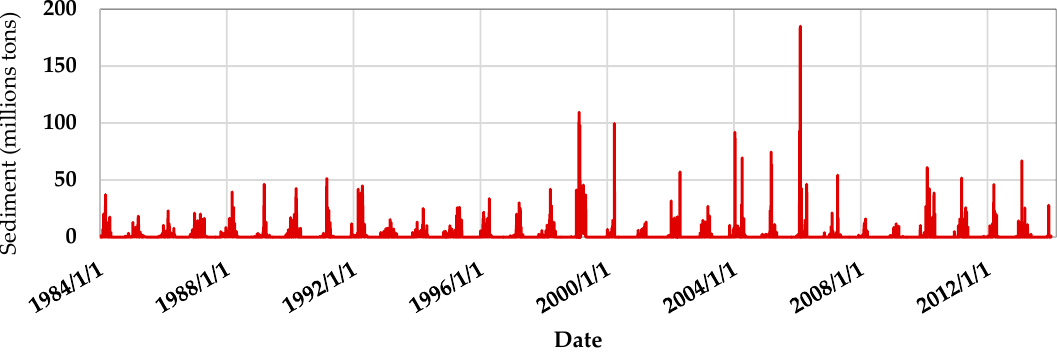
Figure 9. Best simulated sediment inflow into the Derbendkhan Reservoir.